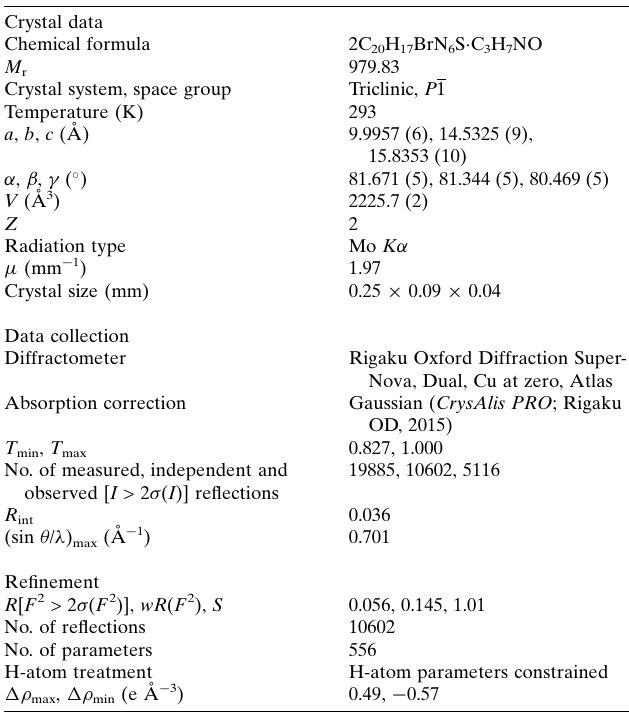
Table 2 Experimental details.